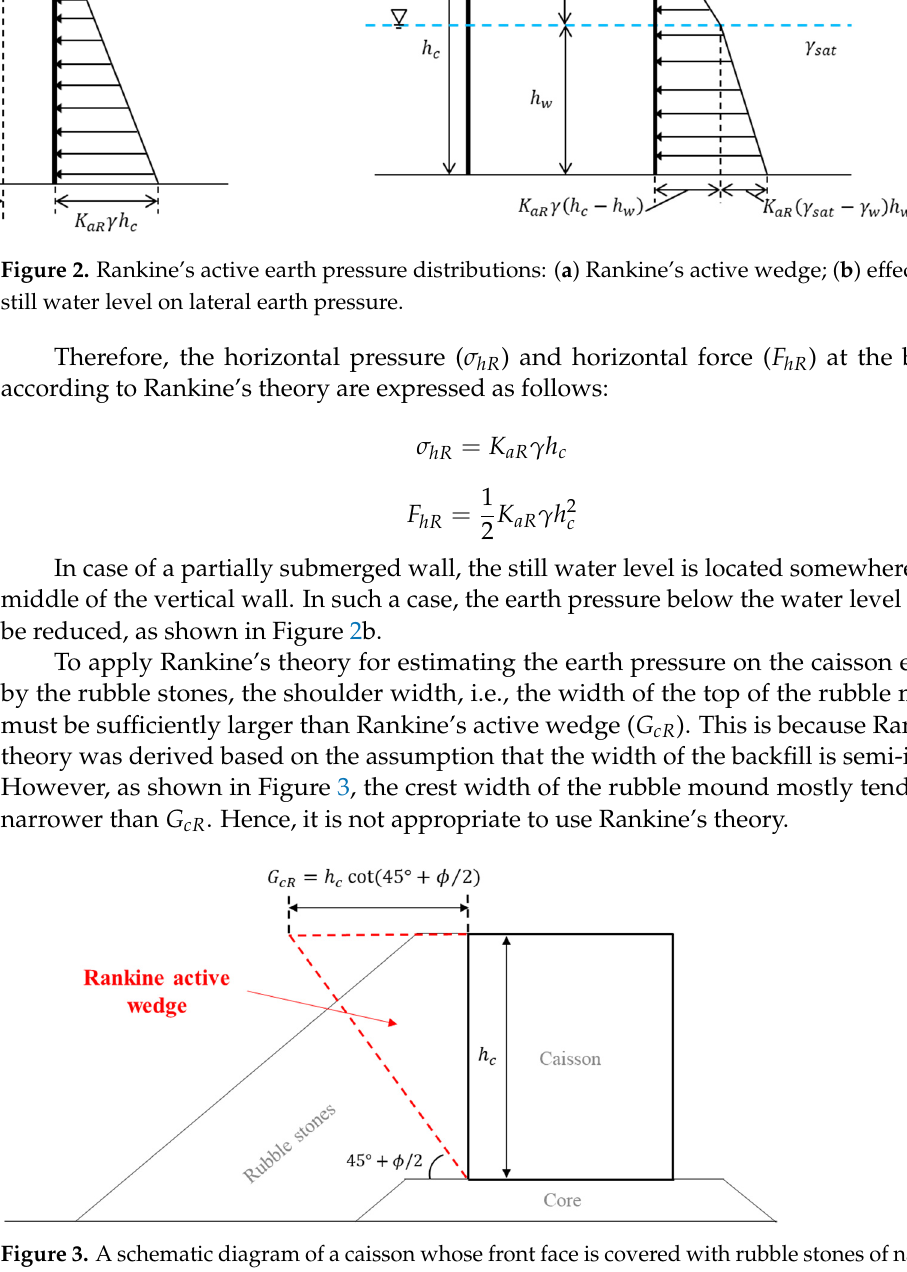
Figure 3. A schematic diagram of a caisson whose front face is covered with rubble stones of nar- rower width than Rankine’s active wedge. width than Rankine’s active